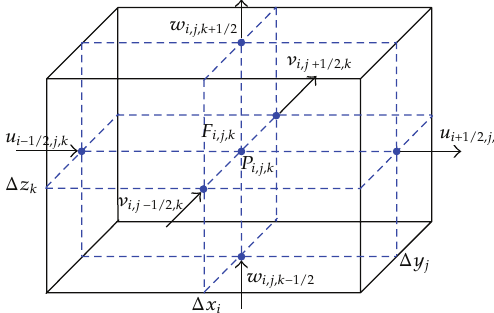
Figure 1: The definition of physical quantity in the Cartesian staggered